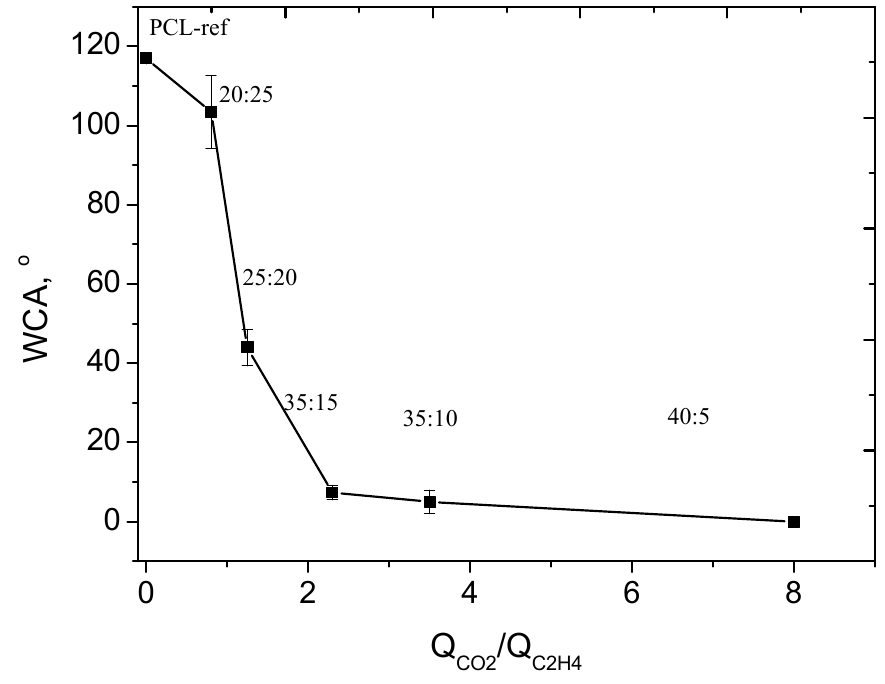
Figure 4. The dependence of WCA on CO 2 :C 2 H 4 ratio (Q CO2 /Q C2H4 ).